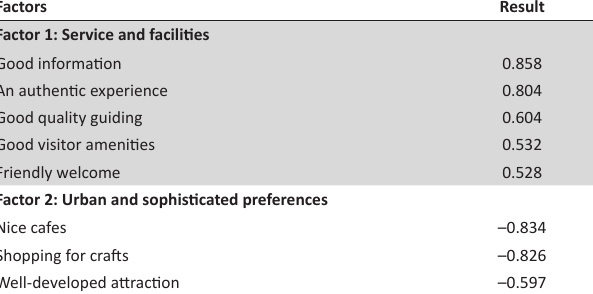
TABLE 5: Factor analysis for important visitor likes when visiting geoheritage sites.